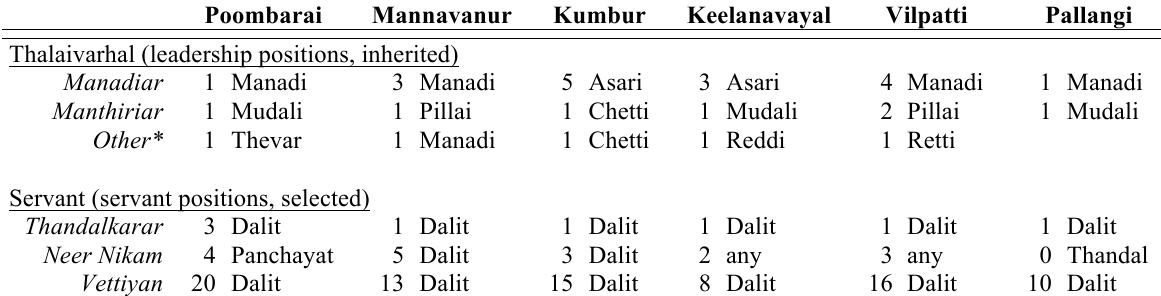
Table A 1. Traditional village positions in the six study villages, by caste occupancy. Sakkliyar is the major Dalit caste in the Palani hills region. Servant positions are selected by the thalaivar ('headmen') for 1-3 yr terms *Other = Village specific thalaivar postions, including Periyathanam (wealthy leader), Maniyakarar, Kariyamanadi, Pattakarar, and Mem-, Chola-, Shantha-,